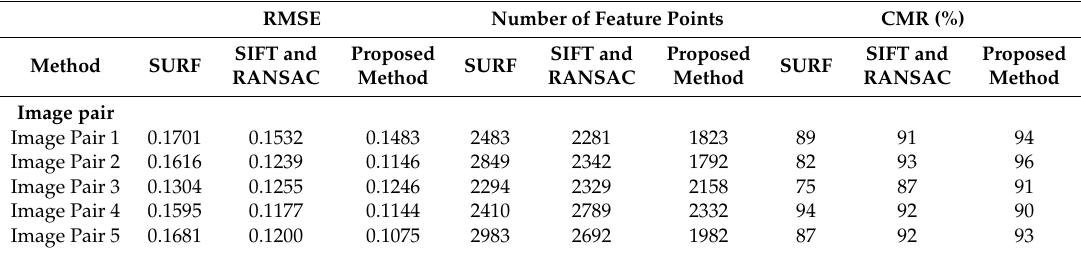
Table 1. Comparison of Root-Mean-Square Error (RMSE) of test image pairs (Figure 5).